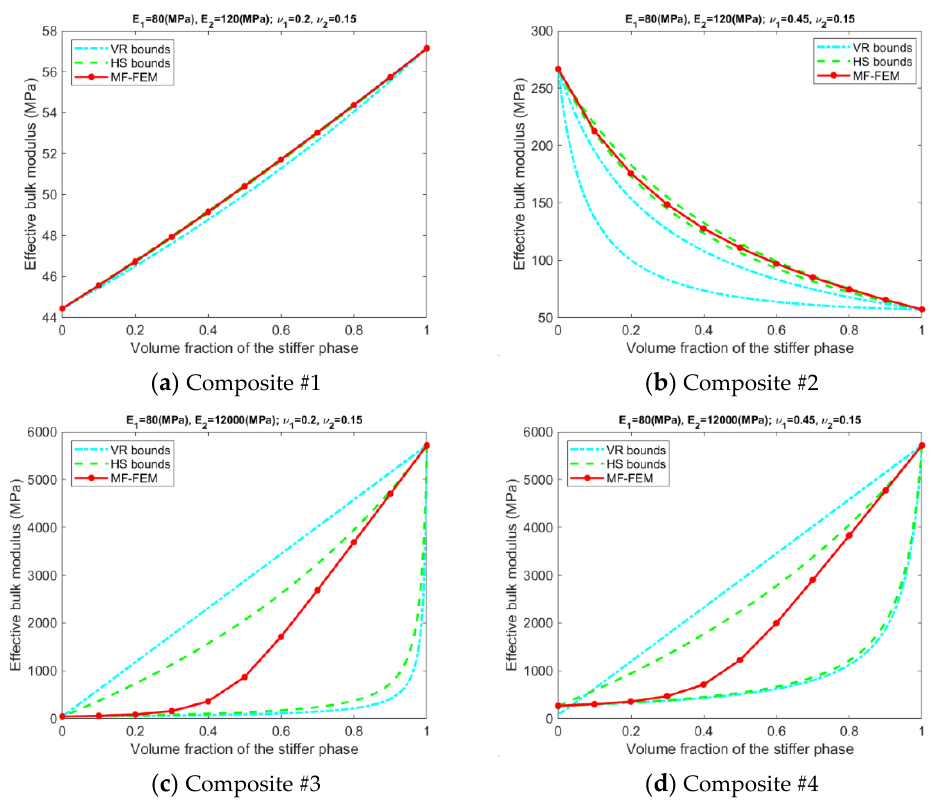
Figure 4. Relation between MF-FEM predictions and VR/HS bounds of effective shear modulus.